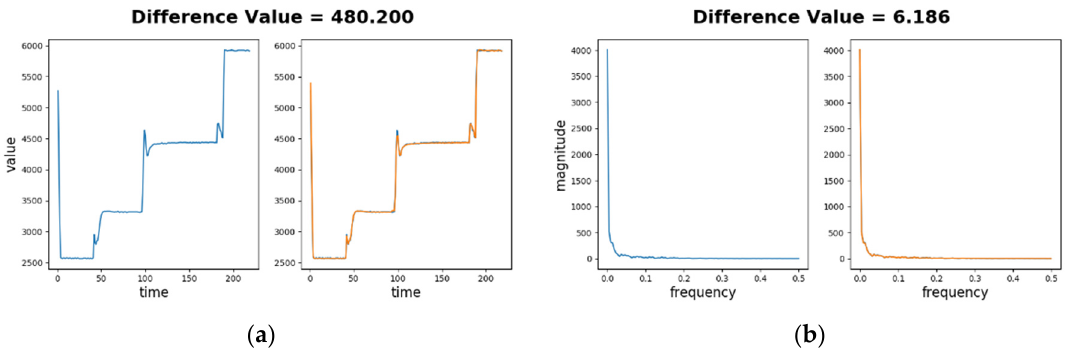
Figure 7. Low difference values of a normal sequence comparing to its decoded sequence: ( a ) in time series forms; ( b ) in frequency spectra forms.